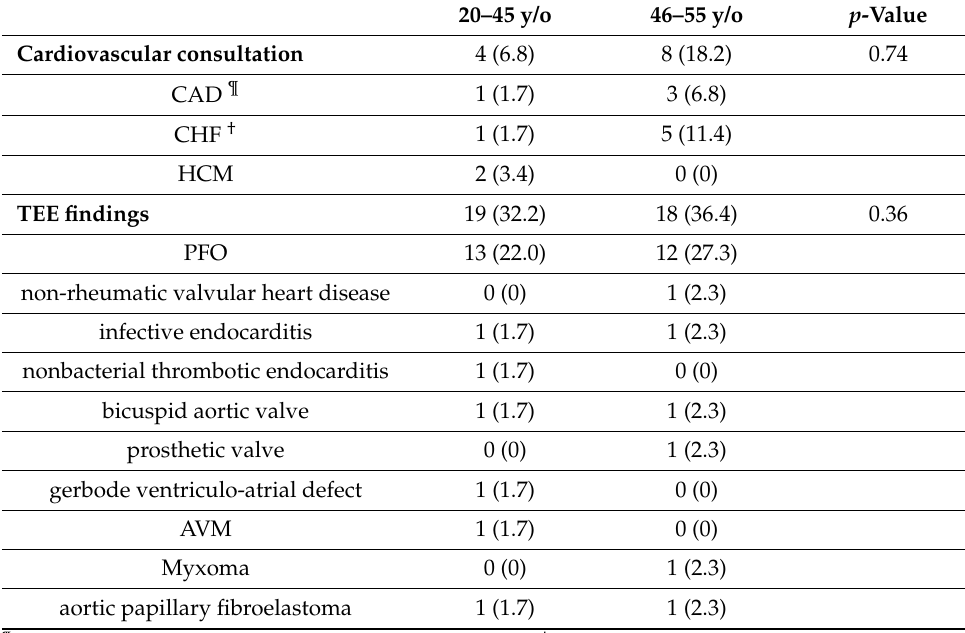
Table 2. Findings of cardiovascular consultation and TEE.